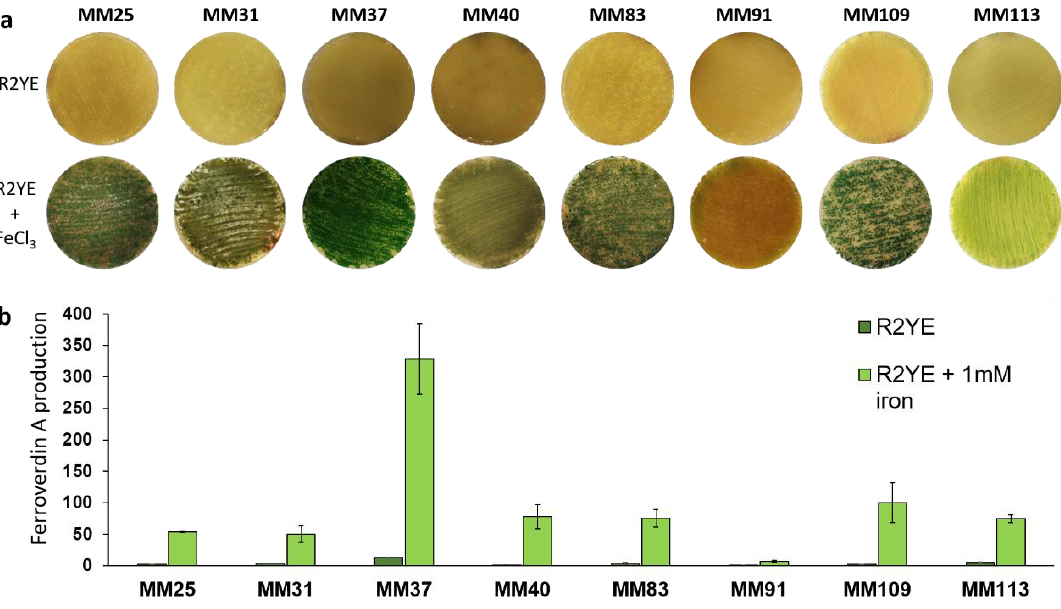
Figure 8. Ferroverdin production in response to iron supply by different strains of S. lunaelactis . ( a ) Induced ferroverdin-associated green pigmentation of S. lunaelactis strains grown on the R2YE medium upon addition of 1 mM FeCl 3 . ( b ) Semi-quantitative evaluation of ferroverdin A production under conditions non-inducing (R2YE) or triggering (R2YE + 1 mM FeCl 3 ) ferroverdin biosynthesis. The production levels were compared to those obtained with strain MM109 T (fixed to 100%). Note the overproduction of strains MM37 and the almost complete loss of production for strain MM91.